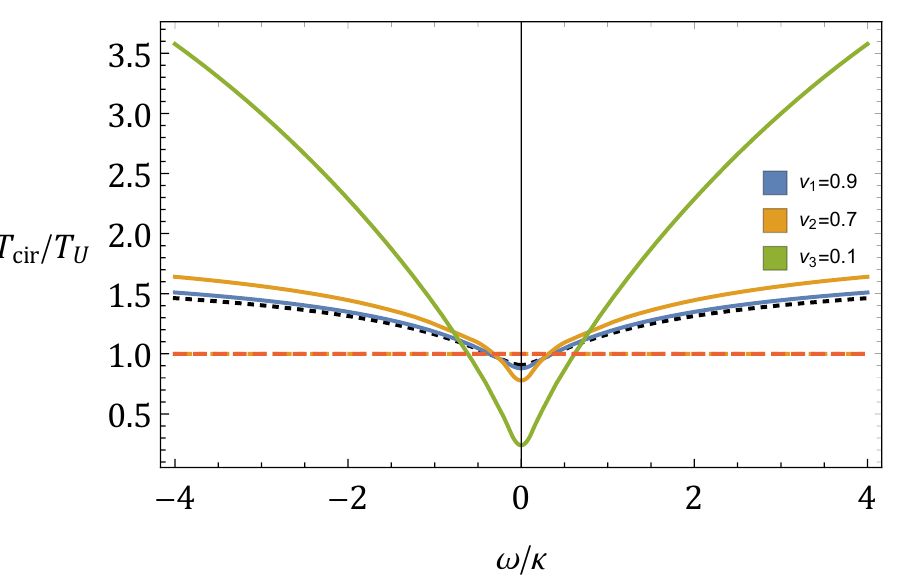
Figure 3 . E(cid:11)ective temperature along the Ultrator (circular) worldline. The Unruh temperature, T U , is indicated by a red dotted line. The Parator (cusped) motion temperature, T cus , is indicated by a black dotted line. At large values of v the Ultrator temperature asymptotes the Parator temperature.